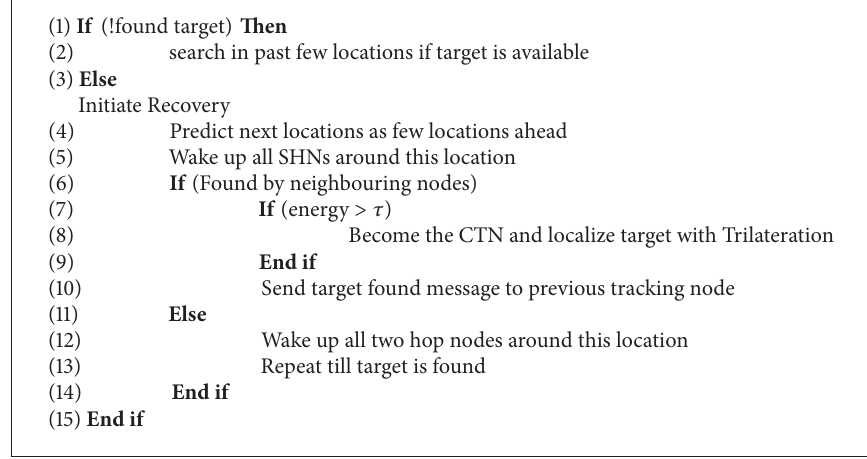
Algorithm 1: Lost target recovery in WSHUN algorithm.